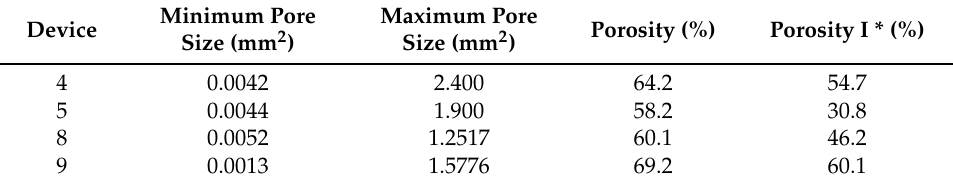
Table 4. Pore size and porosity (area method) of two ‐ guide bar structure devices.